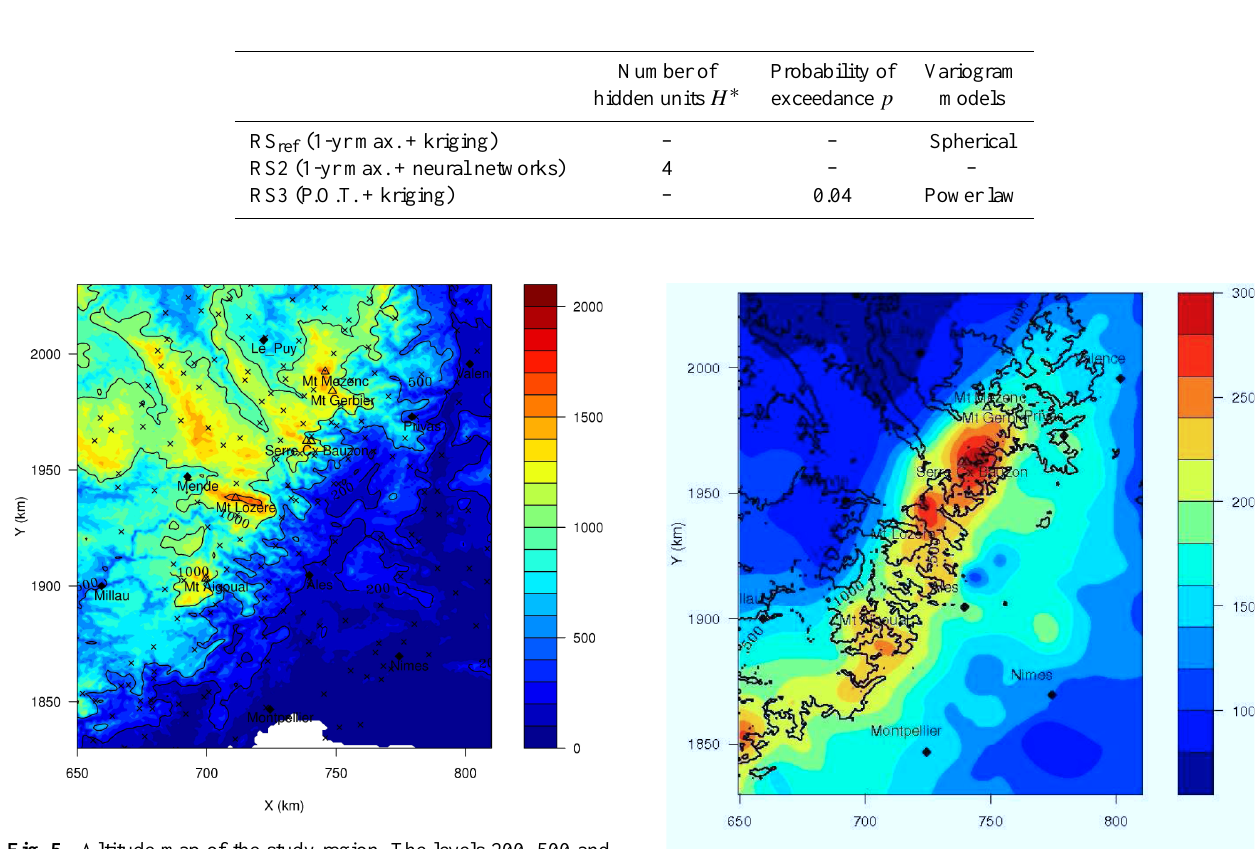
Table 1. Hyper-parameters selected by the inner cross-validation over the 225 stations.